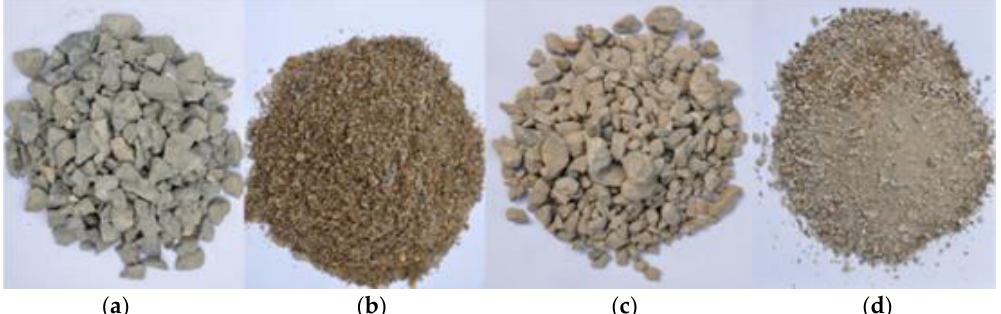
Figure 2. Aggregate sample. ( a ) NCAs; ( b ) NFAs; ( c ) RCAs; ( d ) RFAs.